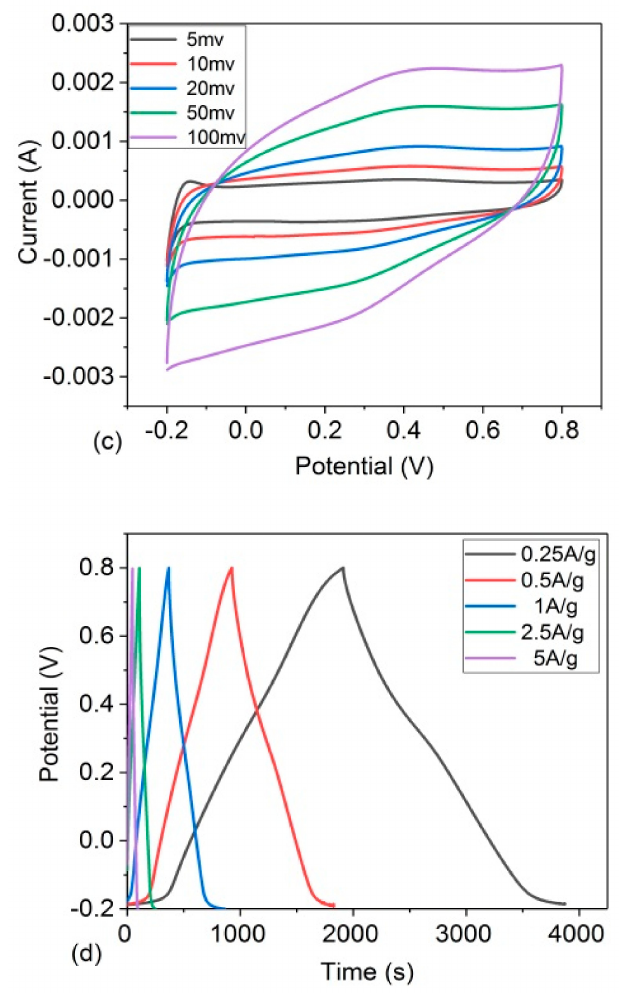
Figure 6. ( a ) Cyclic voltammetry (CV) curves of four carbon materials at the scan rate of 5 mV / s, ( b ) galvanic charge-discharge (GCD) curves of four carbon materials at the current density of 1 A / g, ( c ) CV curves of NCM-900, and ( d ) GCD curves of NCM-900.